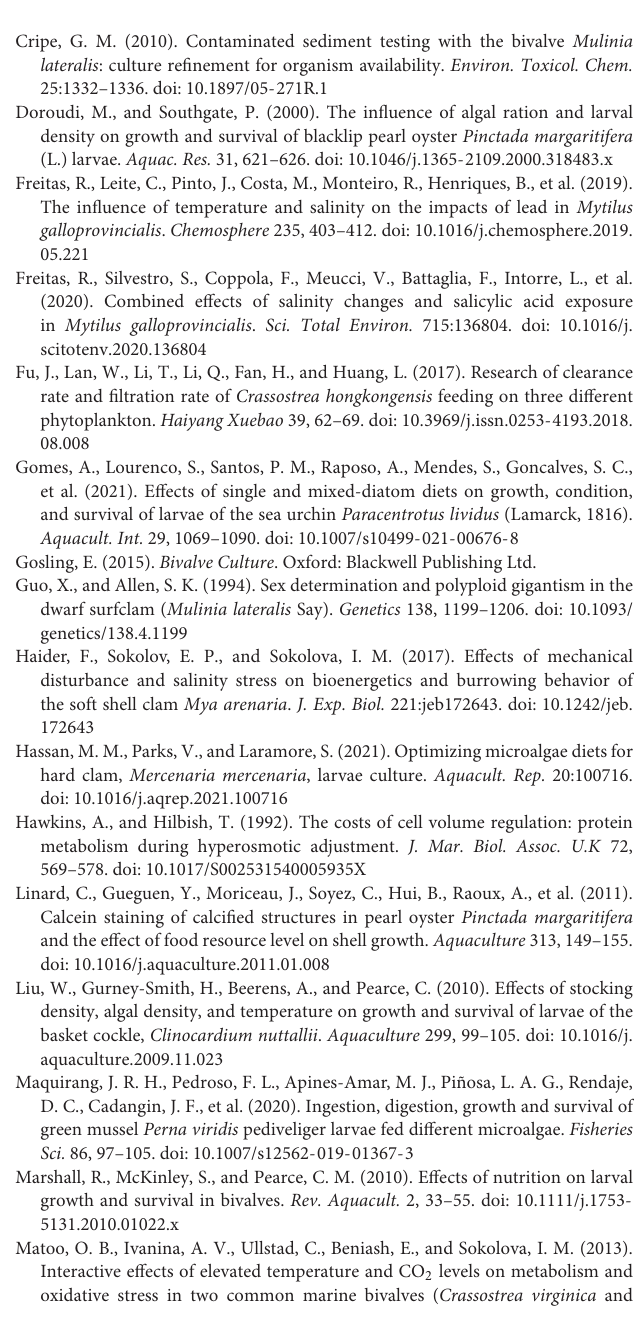
Supplementary Figure 1 | Experimental design used to test the effects of different microalgae diet on the ingestion rates of M. lateralis spat at different ages. Supplementary Figure 2 | Morphological observation of microalgae concentrates under